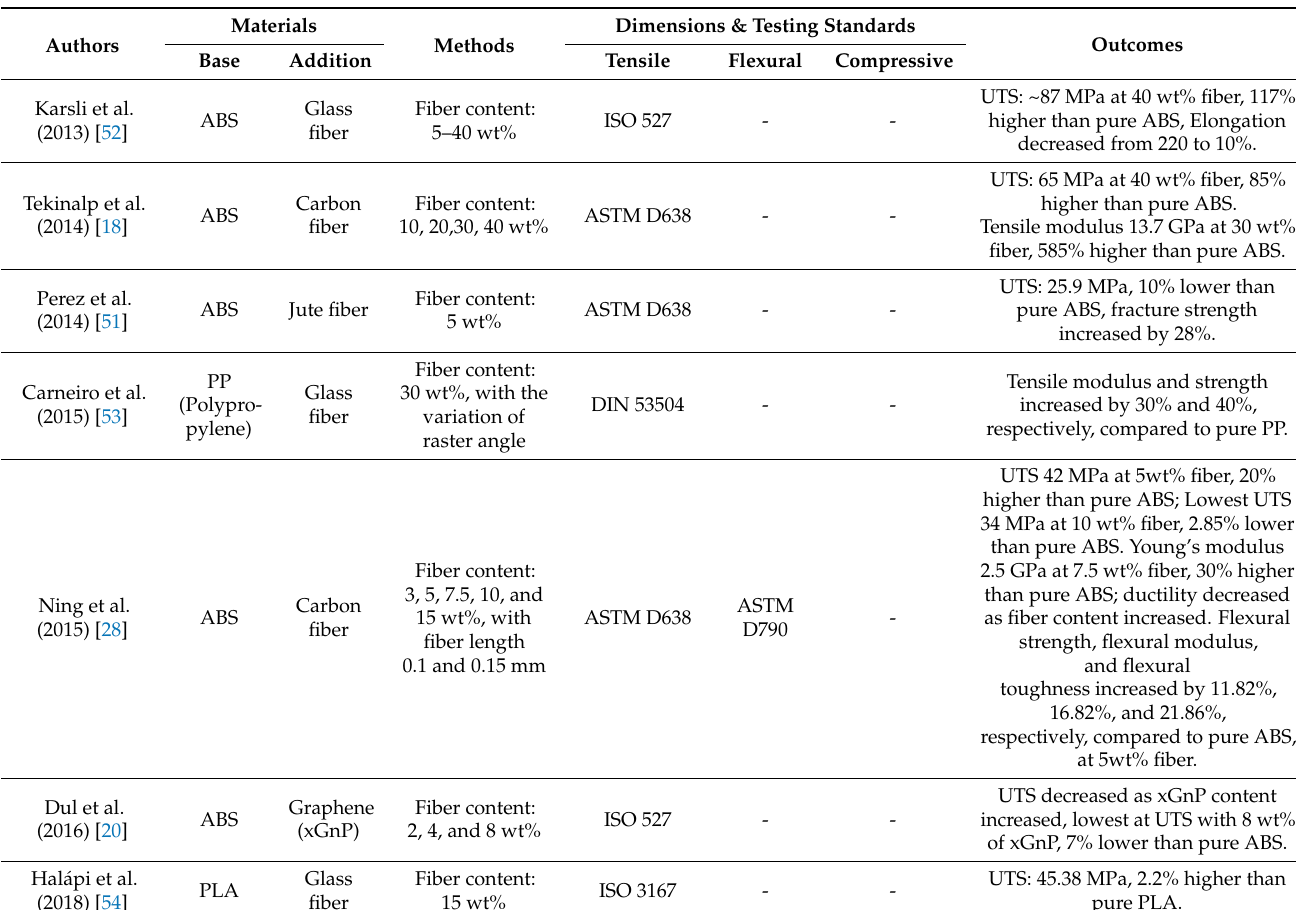
Table 2. Research on Short Fiber